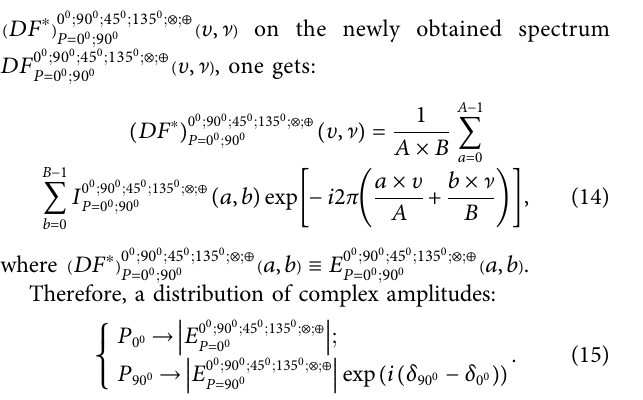
FIGURE3| Embossedtopographicmapsoflinear (A) Φ L ( θ 1 (cid:1) 0 . 4 rad 5 z 1 ≈ 25 μ m ) and (B) Φ L ( θ 2 (cid:1) 0 . 75 rad 5 z 2 ≈ 50 μ m ) ,andcircular (C) Φ C ( θ 1 (cid:1) 0 . 4 rad 5 z 1 ≈ 25 μ m ) and (D) Φ C ( θ 2 (cid:1) 0 . 75 rad 5 z 2 ≈ 50 μ m ) birefringence of myocardial histological